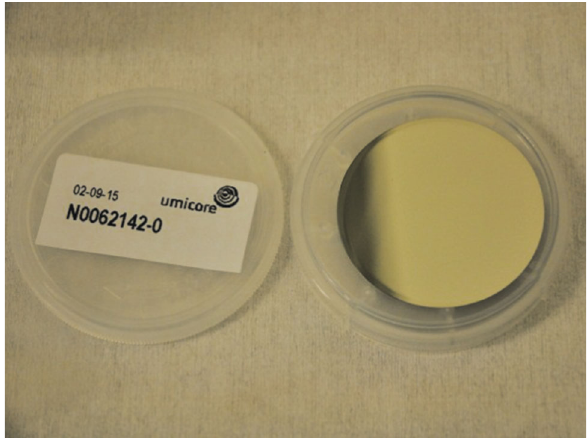
Fig. 5 A high purity Ge slab before applying any procedure